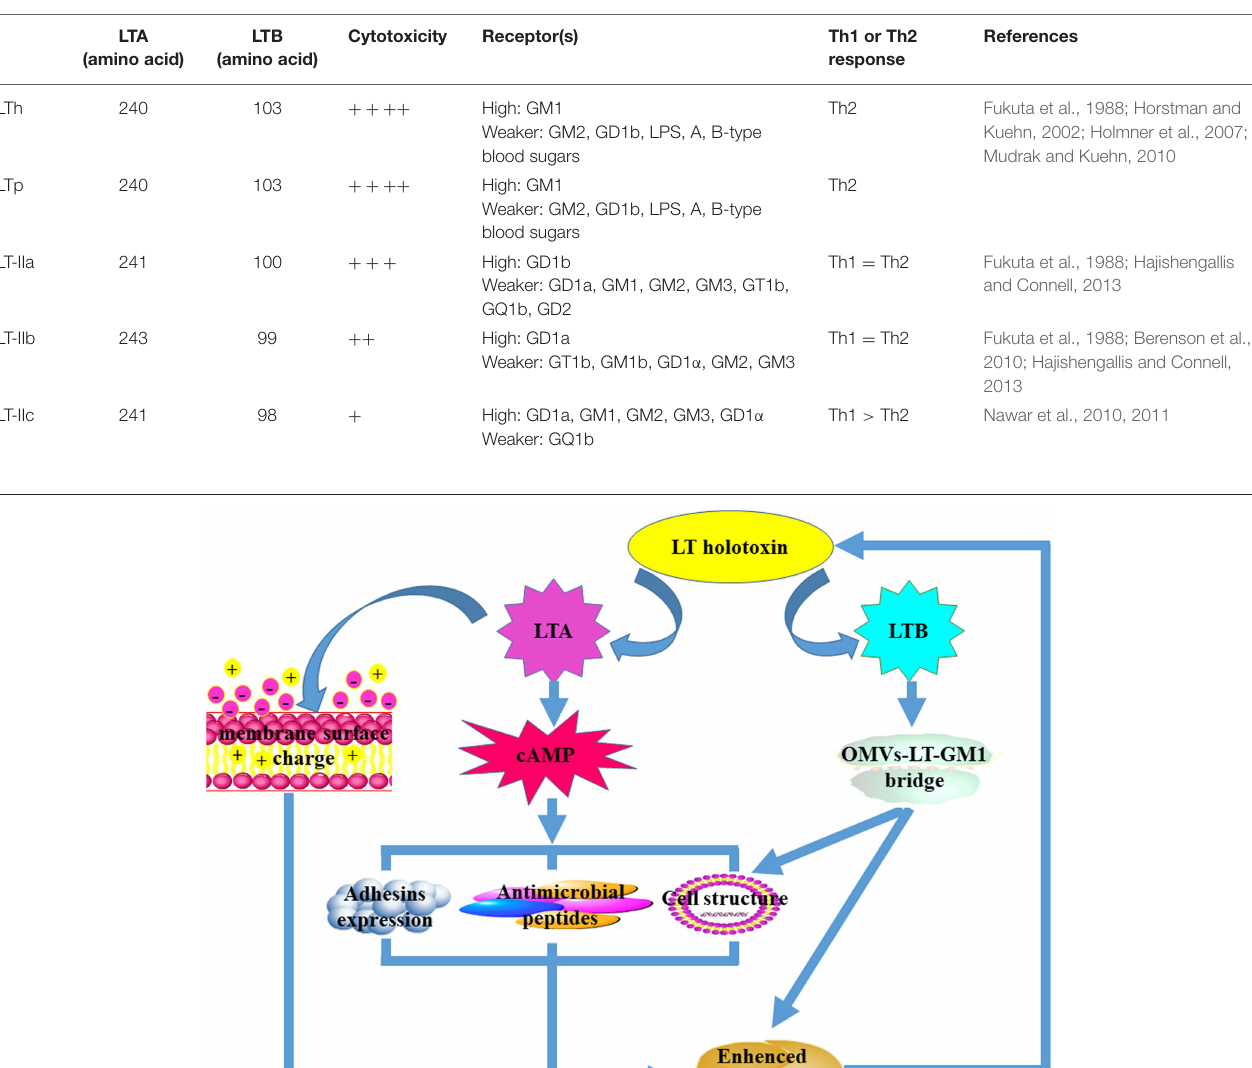
TABLE 2 | Distinct properties of LT and LT-II.